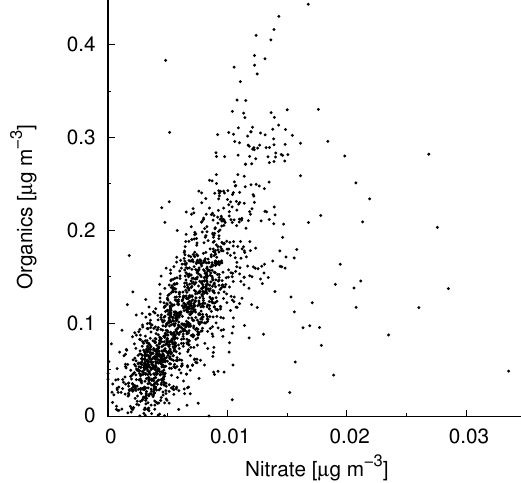
Fig. 6. Scatter plot of organics and nitrate concentrations showing data between 5 August 2006 and 12 October 2006. The consistent overall correlation has an R 2 value of